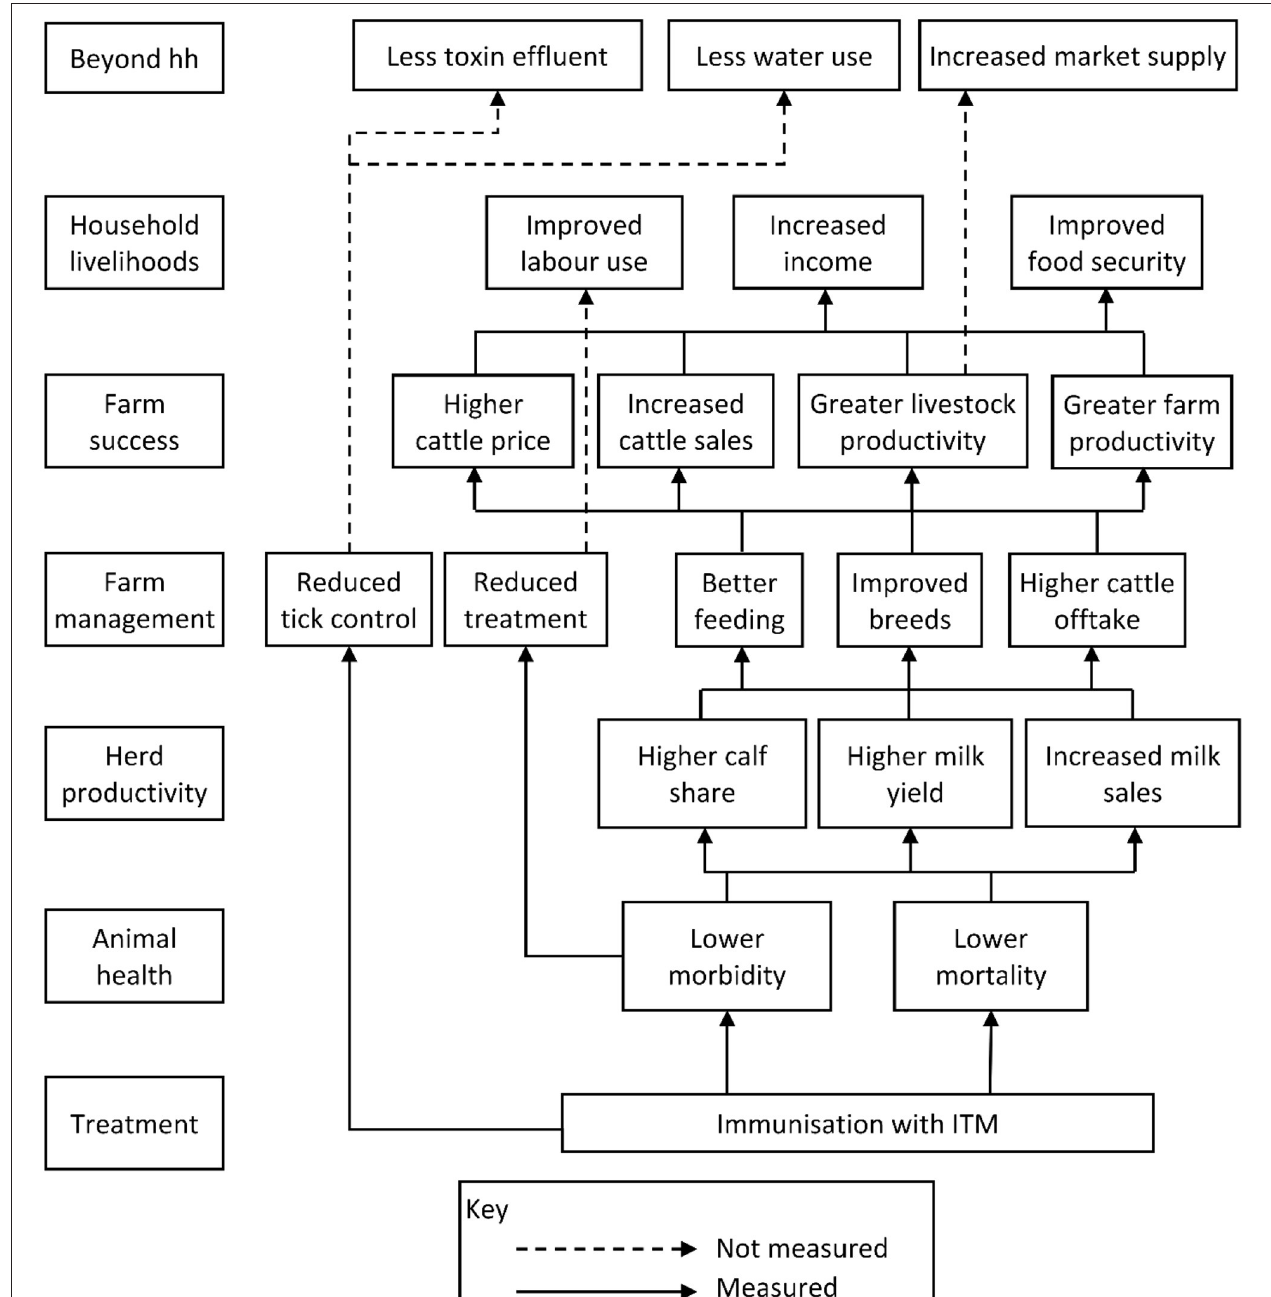
FIGURE 1 | The impact pathways of ITM vaccination and their consideration in this study.